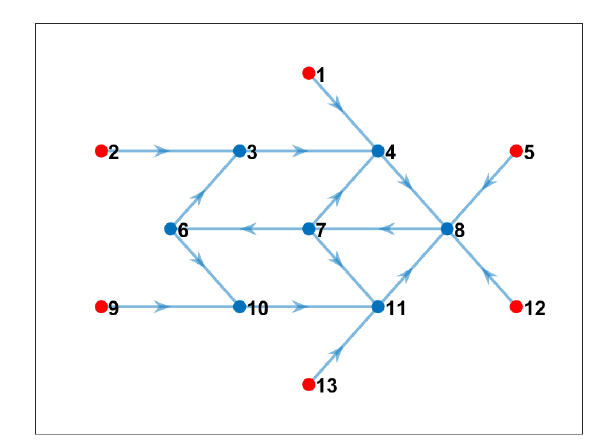
Figure 9. Communication pattern using the proposed model when we considered that one node only can receive data from up to four neighbor nodes (blue nodes are nodes that computed cross-correlation; red nodes only sent data to the corresponding network). Nodes that computed